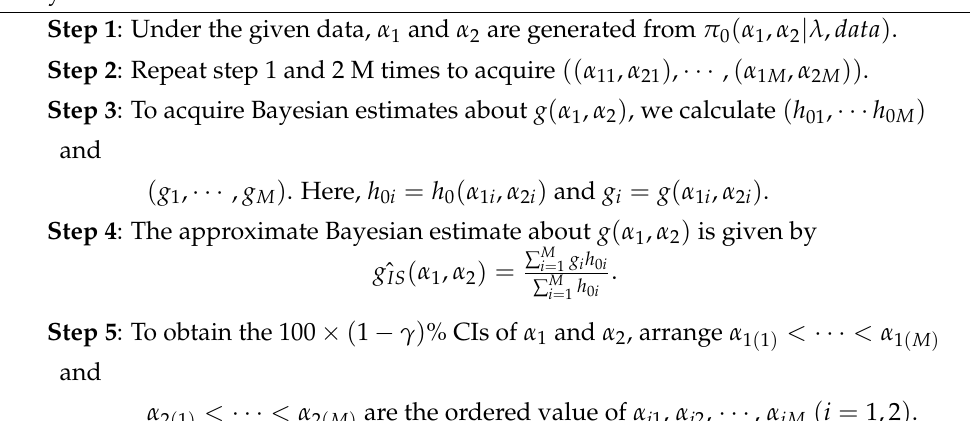
Algorithm A1: The application of the importance sampling technique in Bayesian estimates and HPD credible intervals for known λ